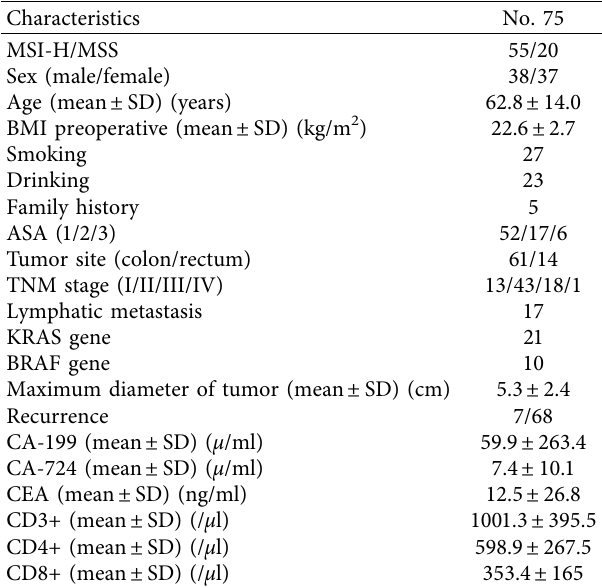
Table 1: Baseline characteristics of CRC patients.